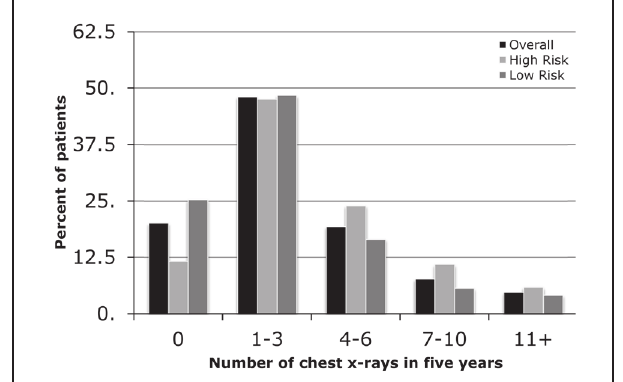
Figure 5) The number of chest x-rays received in the five-year follow-up period, stratified according to high- and low-risk for